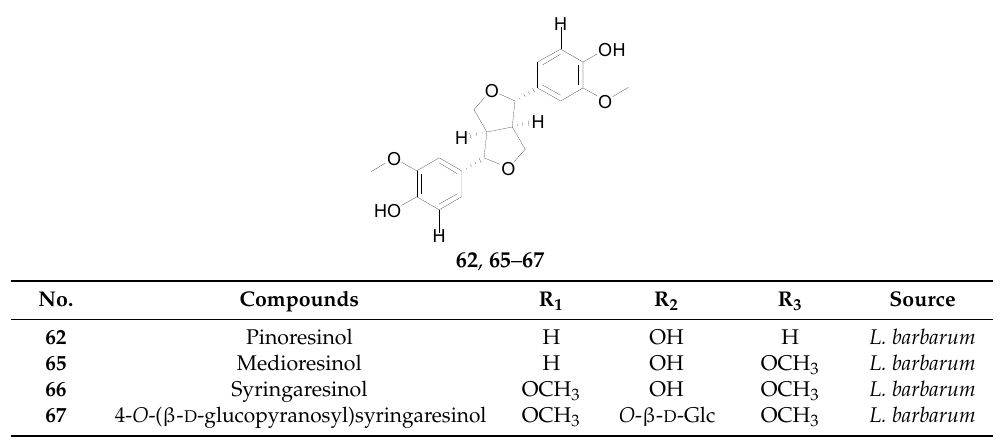
Table 6. Chemical structures of compounds 62 and 65 – 67 .